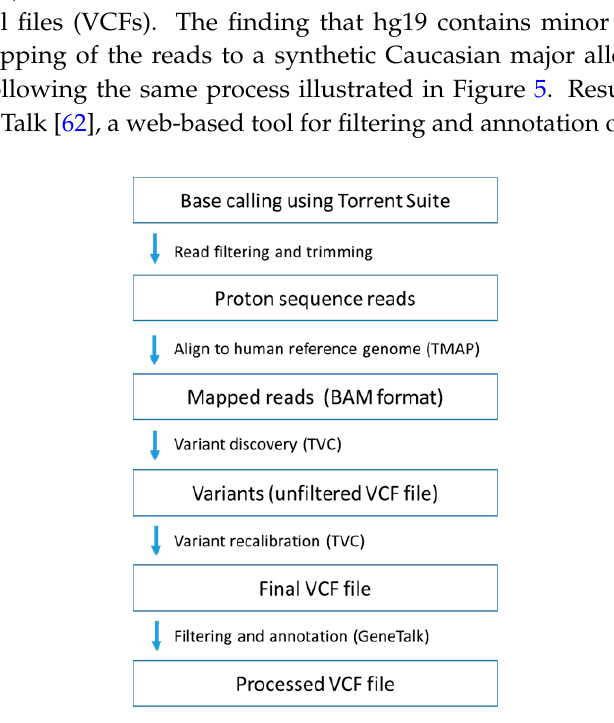
Figure 5. A simplified representation of the data analysis pipeline used by Torrent Suite for the identification of variants in WES data. Base calling, read filtering and trimming were performed by the Torrent Suite software. The torrent mapping alignment (TMAP) [60] program was used to map the resulting reads to the human reference genome. Variant calling was performed by the Torrent Variant Caller (TVC) in three steps: generate candidates, evaluate candidates and filter candidates. Final filtering and annotation of variant call files (VCF) were performed using GeneTalk [62] web-based bioinformatics